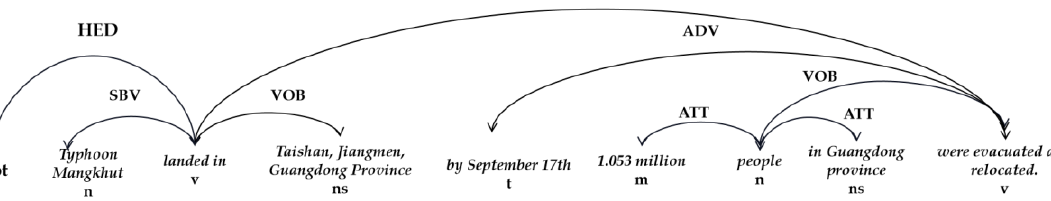
Figure 3. Example of Chinese dependency parsing.